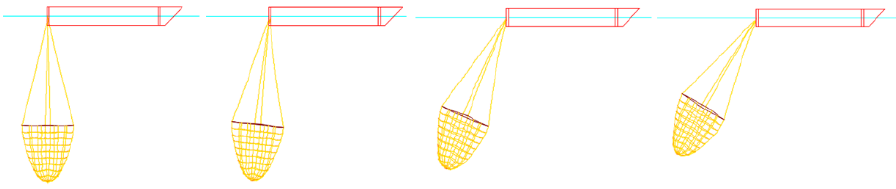
Figure 14. Shape changes of rigid truss trawl in straight-line towing at v = 2 m/s.